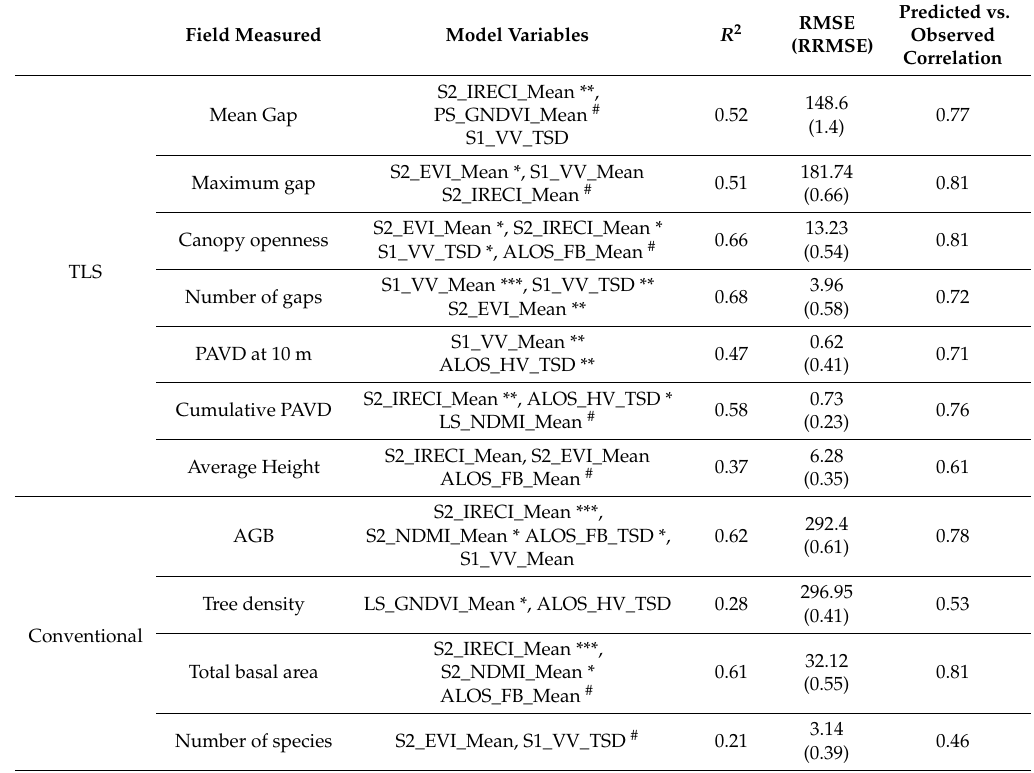
Table 5. Stepwise multilinear regression with Akaike information criterion (AIC) for estimating field-measured forest structure parameters using satellite remote sensing variables. Significance code: 0 ***, 0.001 **, 0.01 *, 0.05 #